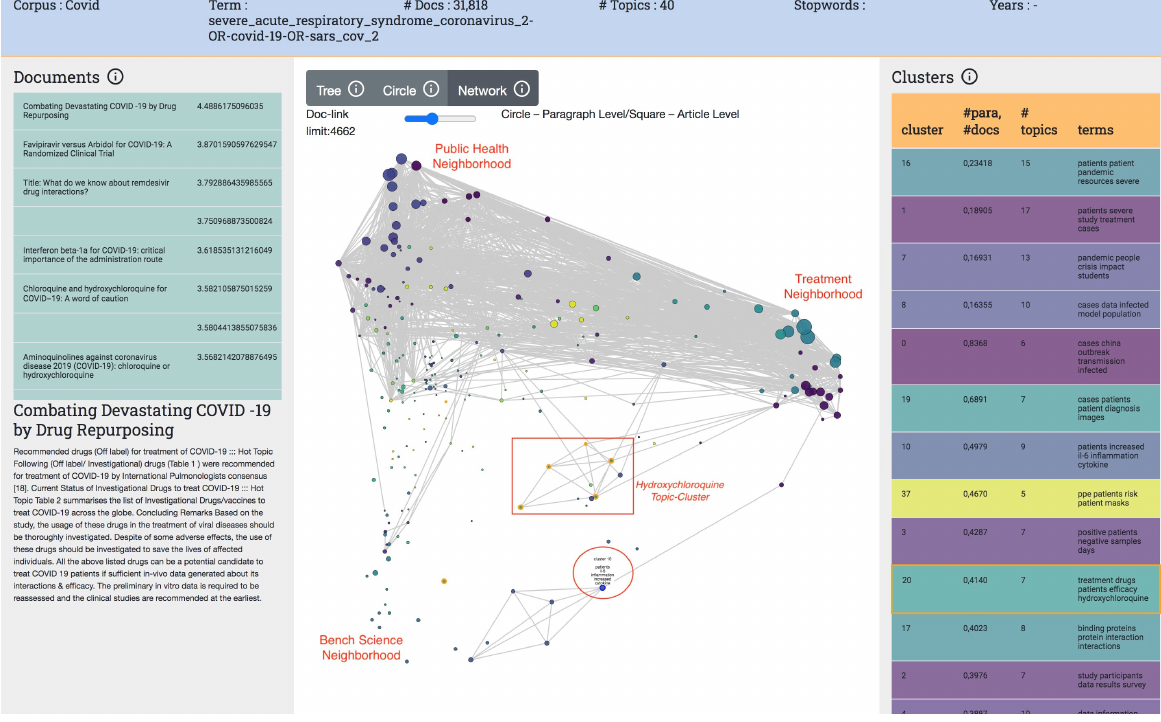
Figure 7. Network visualization of the COVID-19 Topic Model as of